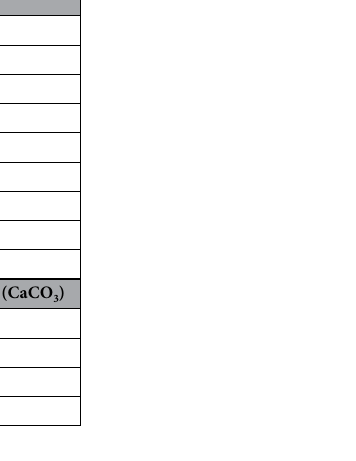
Table 1. Properties of the different biochar used.